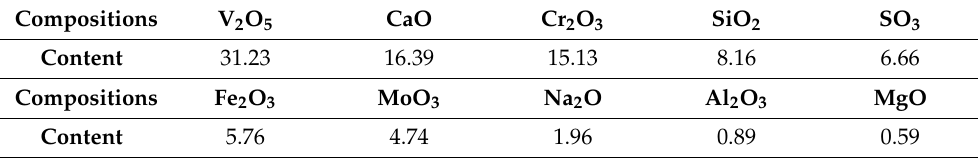
Table 1. Chemical compositions of the HCVR used in this study